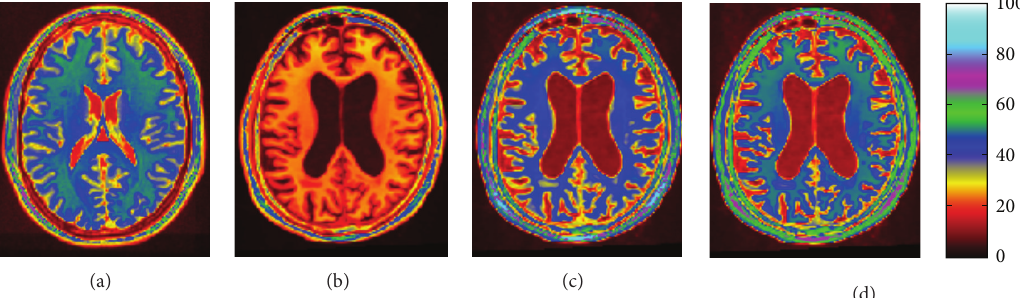
Figure 2: Intensity standardization example for an ADNI subject. From left to right: (a) reference image; (b) original image; (c) standardized image using the Nyul et al. histogram-matching technique [41]; and (d) standardized image using our tissue derived, spatially constrained intensity matching technique [42]. The color map was chosen to increase contrast.